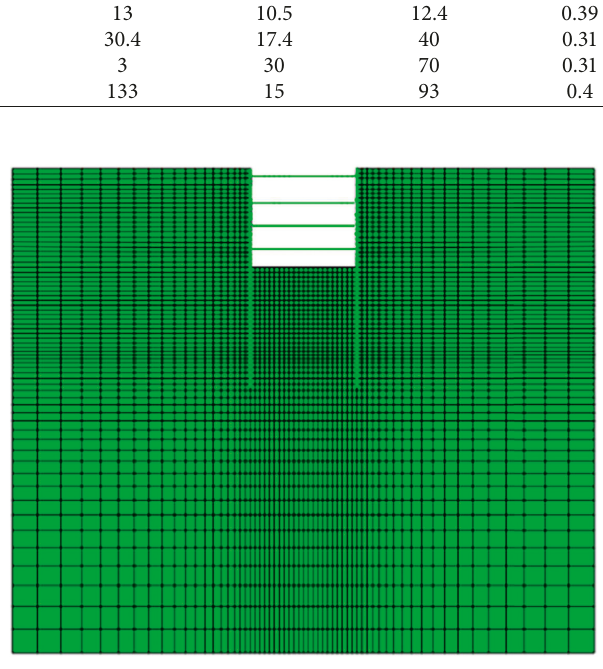
Figure 3: Finite element meshing